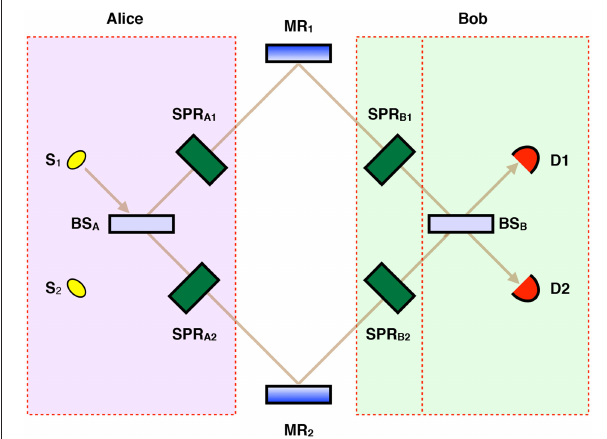
FIGURE 1 | Quantum erasure cryptography. After sending in her photon as shown, Alice encodes bit value “0” by doing nothing, and encodes bit value “1” by applying switchable polarization rotators SPR A 1 and SPR A 2 . Bob encodes bit value “1” by doing nothing, and encodes bit value “0” by applying switchable polarization rotators SPR B 1 and SPR B 2 . Which-path information destroys interference, while the erasure of which-path information restores interference. As explained in the text, for Alice sending in her photon from the top left, D 1 clicking uniquely corresponds to Alice and Bob agreeing in their bit choices, and for Alice sending in her photon from the bottom left, D 2 clicking uniquely corresponds to Alice and Bob agreeing in their bit choices. S’s are single-photon sources. MR’s are mirrors. BS’s are 50–50 beam-splitters. Practically, the upper and lower arms of this interferometer would be implemented using two optical cables, in which case there would be no need for MR’s .